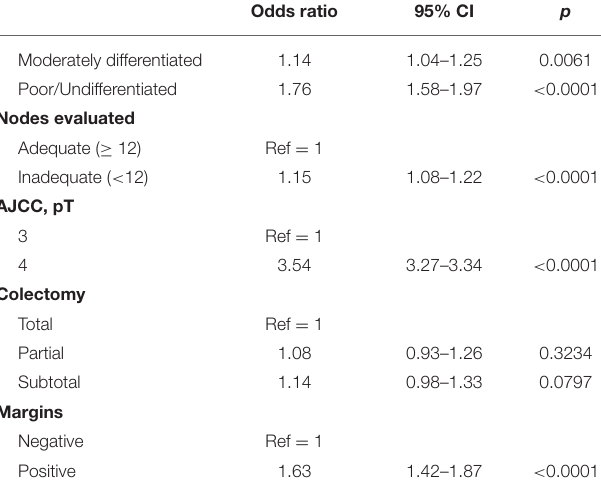
TABLE 3 | Adjusted odds ratios of adjuvant chemotherapy administration based on multivariate logistic